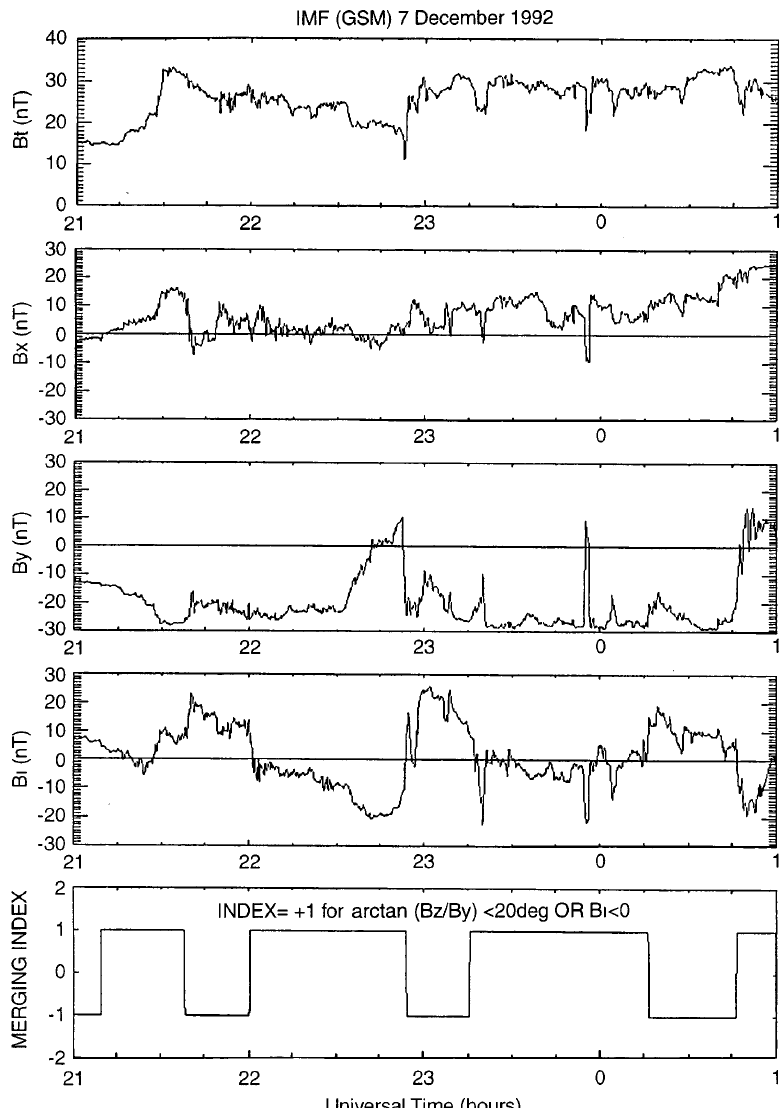
Fig. 2. Magnetic data from Galileo Earth-en- counter II in GSM co-ordinates. The data shown are from 21 UT, 7 December, 1992, to 01 UT, 8 December, 1992 and are averaged over 20 s. During the time period reviewed, Galileo was located in the magnetosheath at GSM coordinates ( X , Y , Z (cid:24) ) 70, 40, 26 R ), su(cid:129)ciently far from E the centre of the tail that the magnetic field data can be used to indicate the strength and orienta- tion of the IMF. The bottom panel indicates the merging index. A value of 1 denotes that the conditions are favourable for low-latitude dayside reconnection, i.e. the IMF B is southward or the z magnetic shear angle between the subsolar mag- netospheric field and the IMF was only (cid:24) 70 (cid:176) when the IMF B z